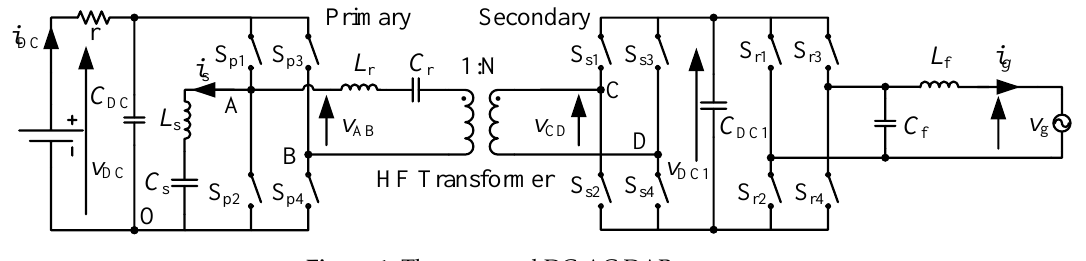
Figure 1. The proposed DC-AC DAB converter.